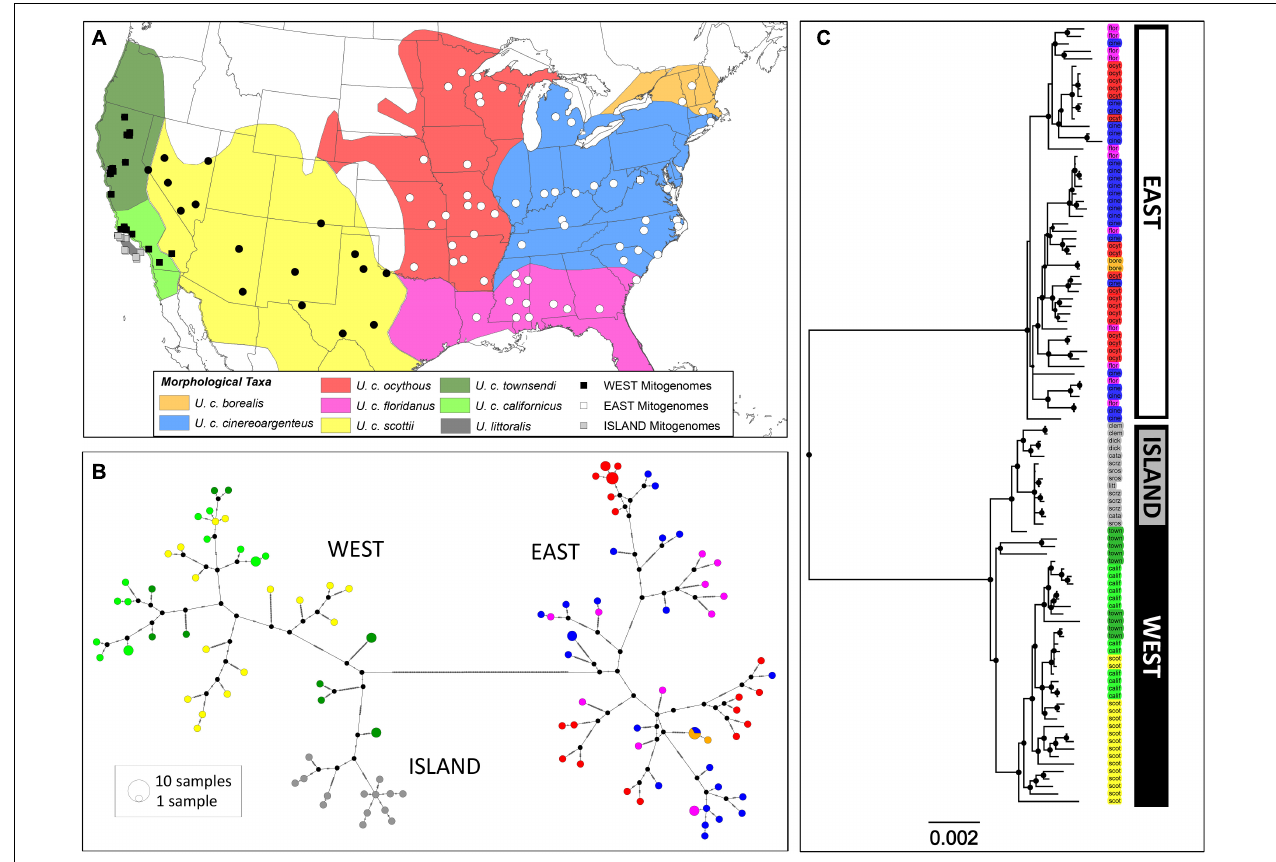
FIGURE 2 | Phylogeographic patterns of United States distribution of Urocyon taxa based on mitogenome sequence data. (A) Map shows distributions of the morphologically-based Urocyon taxa and locations of mitogenome samples ( n = 115) used in the analysis, including newly generated sequences (circles) and previously published sequences (squares). Samples are colored according to whether its mitogenome haplotype fell into the East (white), West (black), or Island (gray) clade. (B) Median joining network of mitogenomes from 115 samples, including newly sequenced U. cinereoargenteus samples ( n = 75) and a subset of samples from Hofman et al. (2015) downloaded from GenBank ( U. cinereoargenteus , n = 26; U. littoralis , n = 14). Each circle represents a unique haplotype, with size proportional to frequency, as well as a pie chart with color indicating the morphologically-based taxonomic assignment of the corresponding samples as shown in the map. Black circles reflect inferred haplotypes not present in the dataset, and hash marks on the lines connecting haplotypes represent the number of mutations separating them. A minimum of 286 steps separates East and West haplotypes. (C) Bayesian tree based on the analysis of 104 unique Urocyon mitogenome haplotypes and two outgroups ( Vulpes vulpes and Canis latrans , removed for clarity). Nodal support for clades is depicted by the size of black circles, with most clades showing posterior probability values ≥ 0.99 (see Supplementary Figure 5 for precise values). Sample codes are colored to reflect the morphologically-based taxonomic